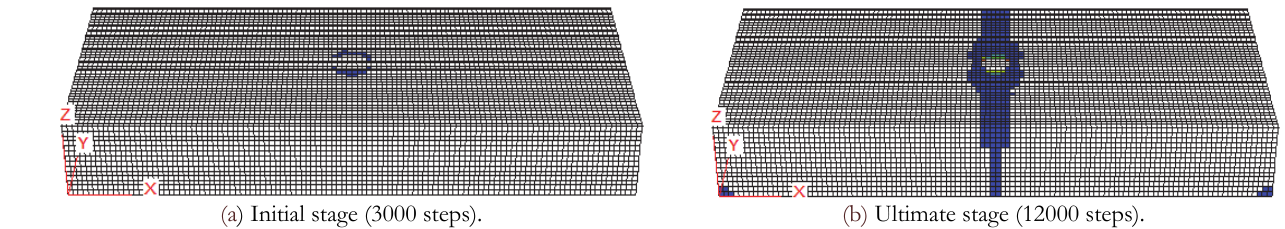
Figure 8: AE locations on the top of the rock plate.